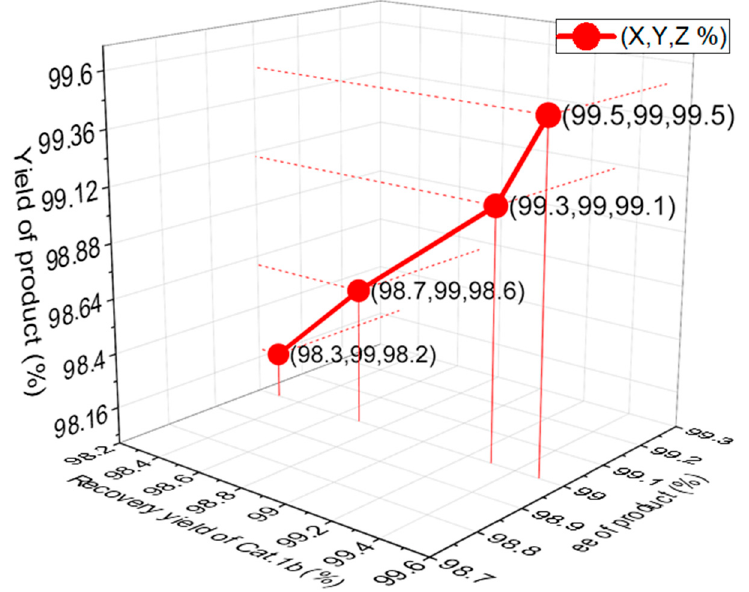
Figure 6. Recycling test for asymmetric Michael addition using chiral ( R , R )-1,2-diphenylethylene- diamine-derived thiourea catalyst ( 1b ).